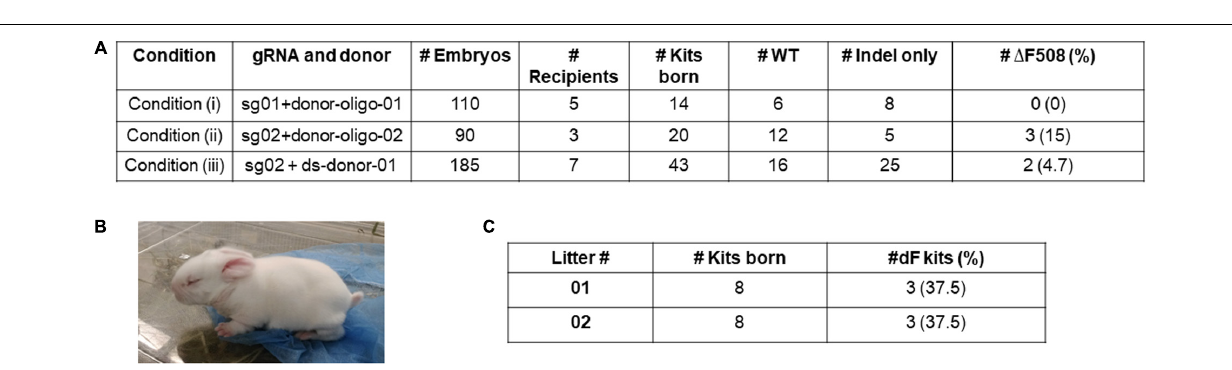
FIGURE 1 | Design and validation of guide RNAs. (A) illustration of gRNA design. Blue box: sgRNA sequence. Bold letters within the blue box: PAM sequence. Yellow box: the F508 or the (cid:49) F508 sequence. (B) In vitro validation results of sg01 and sg02.